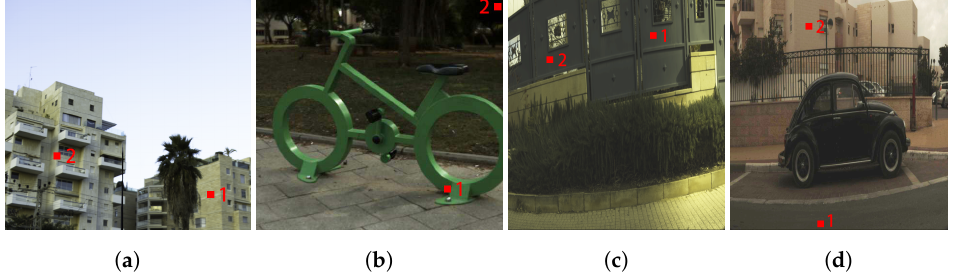
Figure 10. Two selected samples in each example image. ( a ) NTIRE 2018 “Clean” track. ( b ) NTIRE 2018 “Real Word” track. ( c ) NTIRE 2020 “Clean” track. ( d ) NTIRE 2020 “Real Word”